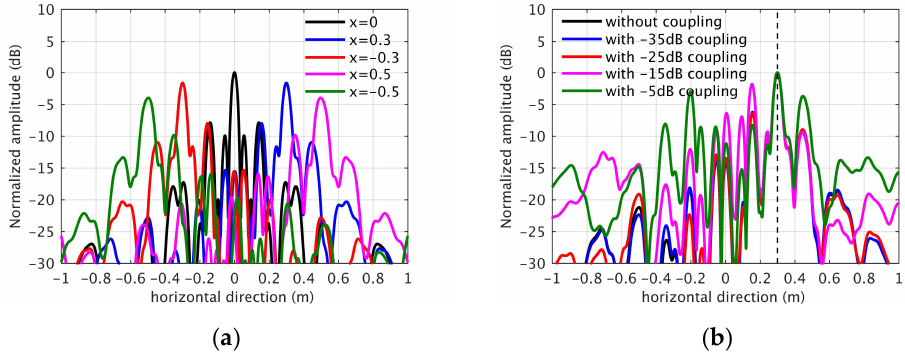
Figure 3. ( a ) Broadband-normalized pattern of beam focusing at different positions; ( b ) examples of patterns at different coupling levels, for which the beam-focusing position is at x = 0.3 m.